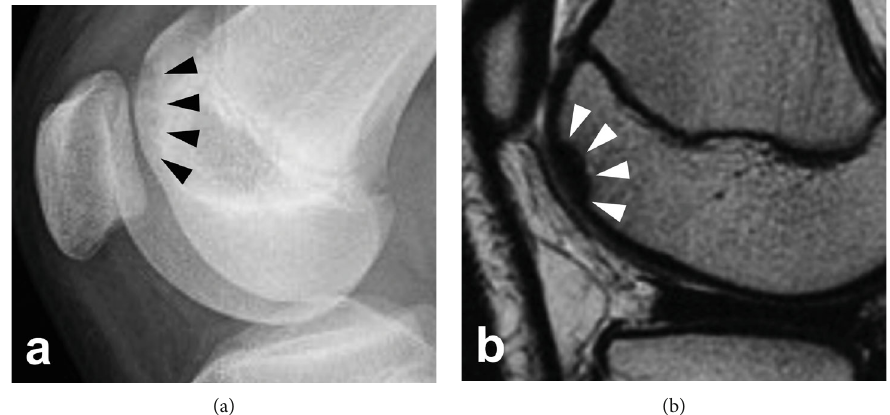
Figure 5: (a) Lateral view radiograph of the right knee showing Brückl ’ s stage II OCD lesion in the lateral facet of the femoral trochlea. (b) T2- weighted MRI sagittal image of the right knee indicating Nelson ’ s stage I lesion in the lateral facet of the femoral